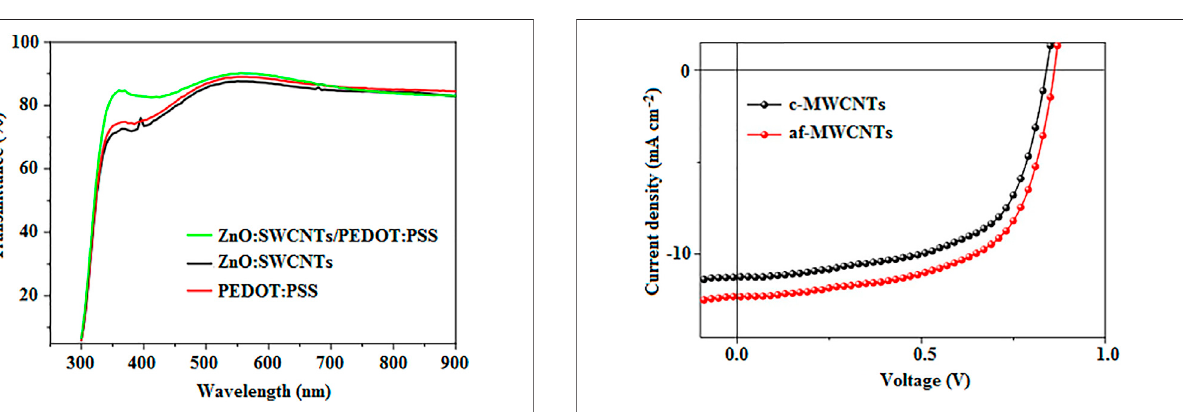
FIGURE7| TheopticaltransmittancespectraofZnO:SWCNTs/PEDOT: PSS, ZnO:SWCNTs and PEDOT:PSS fi lms on ITO-coated glass substrates. Adapted with permission (Mbuyise et al., 2017). Copyright 2017, Elsevier.